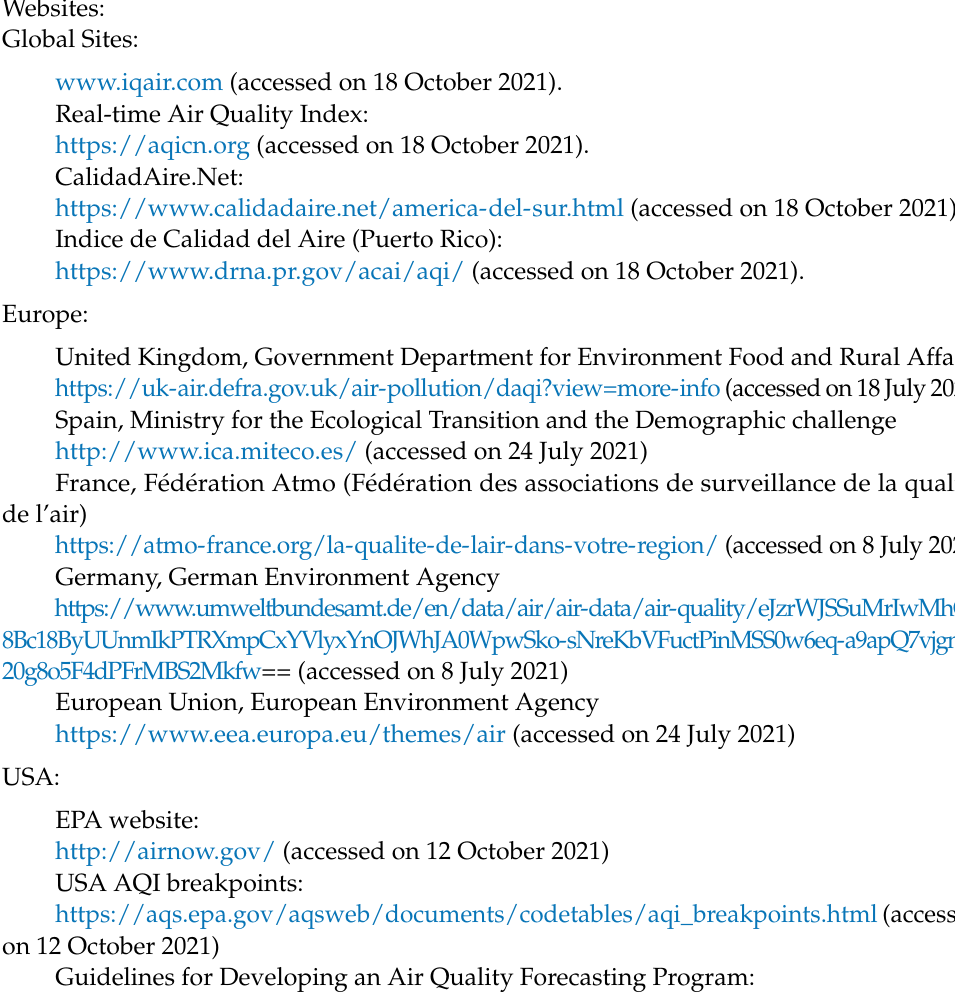
AQI classification, Table S41: Republic of Korea’s AQI health statements, Table S42: Information AQI classification, Table S45: Chinese Indicators for Air Quality Index, Table S46: Thailand’s ambient air quality standards, Table S47: Thailand’s AQI classification, Table S48: Thailand’s AQI Health messages, Table S49: Australia’s ambient air quality standards, Table S50: Air Quality Categories (AQC) cut-off values in New South Wales (Australia), Table S51: AQI health messages in New South Wales’s